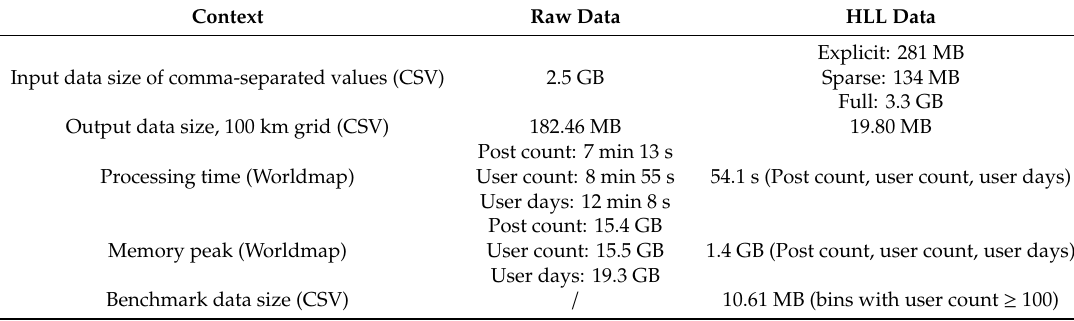
Table 2. Performance benchmark results for raw and HLL data processing (100 km